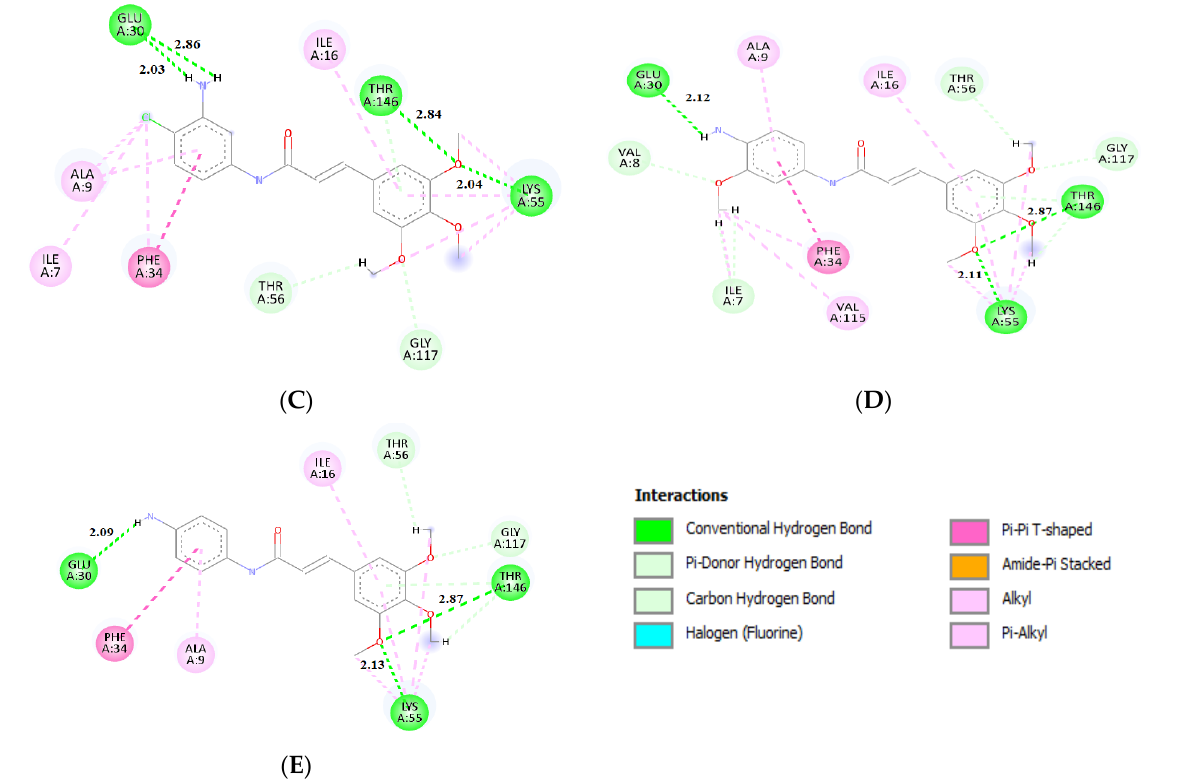
Figure 7. Interactions between molecules ( A ) 2 , ( B ) 6 , ( C ) 13 , ( D ) 14 , ( E ) 16 , and residues in the active site pocket of h DHFR, from molecular docking calculations. Conventional hydrogen bonds lengths are in (Å ).